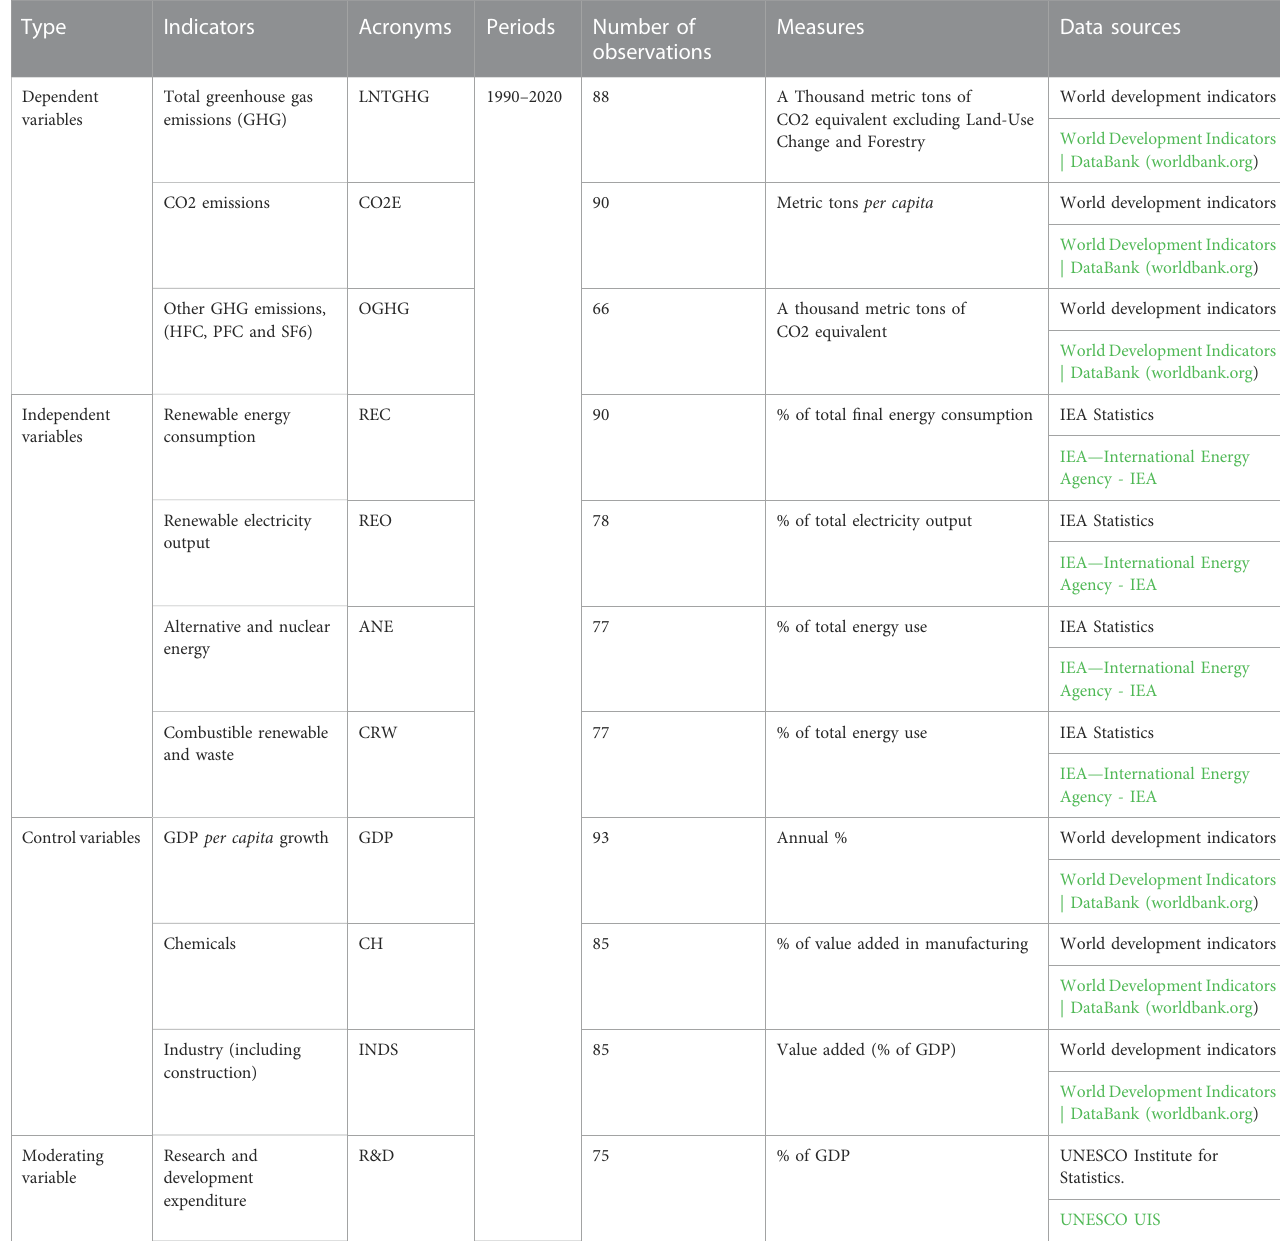
TABLE 2 Variables: de fi nition, measures and data sources.